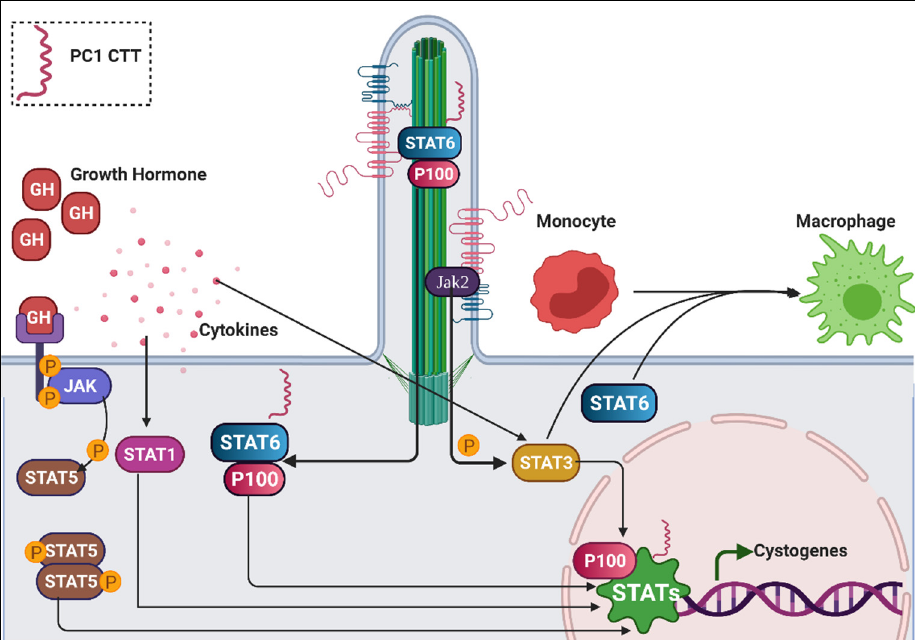
Figure 6. Janus kinase (Jak)/signal transducer and activator of transcription (Stat) pathway in cysto- genesis: In the absence of flow, ciliary PC1 activates Jak2 which STAT3. Lack of flow also triggers PC1 CTT cleavage which activates STAT6 and NF-kappaB p100 (P100). STATs along with P100 translocates to the nucleus mediating transcription of genes required for cell proliferation, migra- tion, development, differentiation, and immune responses. Cytokines released due to renal injury and immune response triggers may activate STAT3 and STAT1. Growth hormone (GH)-mediated signal transduction activates STAT5. STAT3 and STAT6 also facilitate monocyte differentiation to macrophage. These translocate to the nucleus mediating the expression of Jak/Stat downstream tar- gets. (Modified and redrawn using BioRender.com [150,189] ).